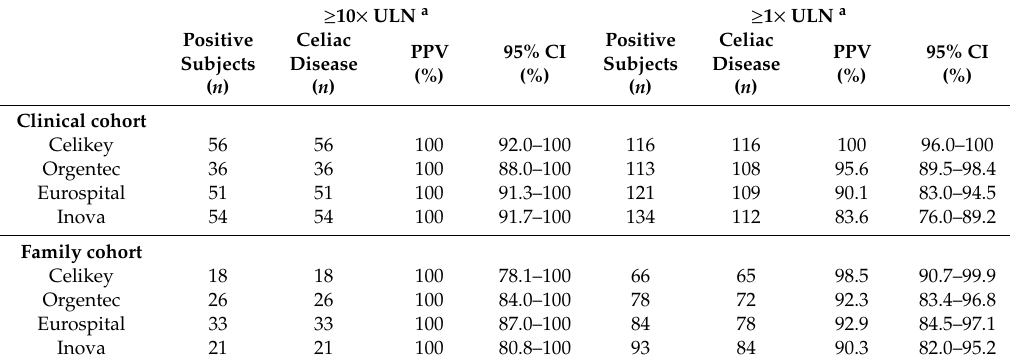
Table 2. Positive predictive values (PPV) of the four study tests for celiac disease in the clinical and family cohorts. ≥ 10 × ULN a ≥ 1 × ULN a